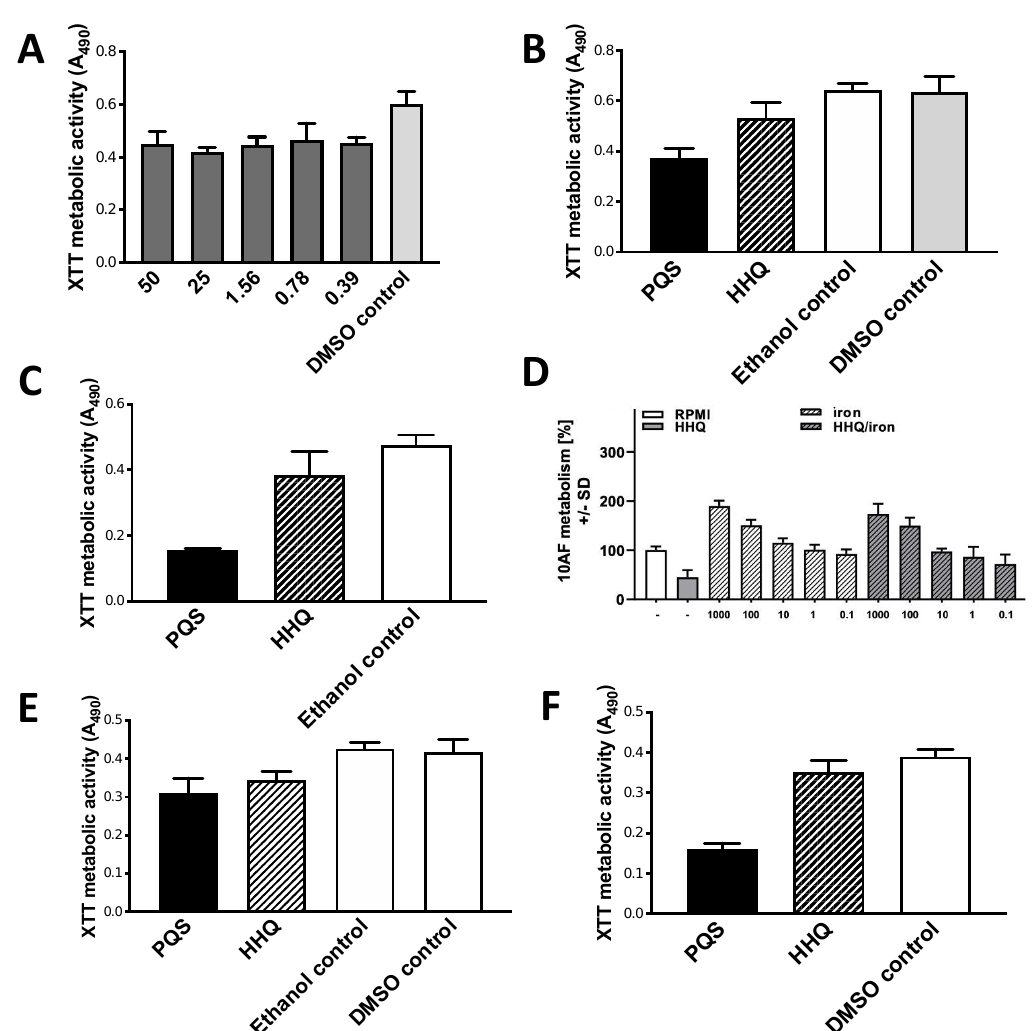
Figure 8. HHQ inhibits Af preformed biofilm; comparison to PQS. ( A ) Dose-response study with preformed 10AF biofilm. Flat dose-response shown. “DMSO control” is same concentration of DMSO diluent as present in test article wells. Twofold dilutions of HHQ were made from 50 to 0.39 µ g/mL. Bars showing results with 3.12–12.5 µ g/mL were not different from the 1.56 or 25 µ g/mL bars, so are not shown in order to simplify the figure. All concentrations shown were p < 0.001 compared to control except 0.78 µ g/mL, which was p < 0.01. ( B ) through ( F ): molecules tested at 1.56 µ g/mL. DMSO control results same as ethanol control or RPMI alone control, in every panel. ( B , C ), comparison with PQS. ( B ) HHQ and PQS inhibit strain 10AF compared to respective controls, p < 0.01 and p < 0.001, respectively. PQS more potent than HHQ, p < 0.001. ( C ) HHQ inhibits strain Af293 by 15%, but not significantly. PQS different from HHQ and control, p < 0.001 both comparisons. ( D ) Reversal of inhibition by Fe, no boosting above Fe alone at high Fe concentrations, Af strain 10AF. Fe was diluted twofold from 1000 to 0.1 µ M final concentrations (these are the numbers on the x axis), in presence or absence of HHQ. Data presented as % of controls. HHQ alone was inhibitory compared to control, p < 0.001 (left two bars). At Fe 0.1 µ M + HHQ (right bar), inhibition by HHQ is partially reversed; the combination still shows inhibition compared to control ( p < 0.05), but less inhibition ( p < 0.05) compared to HHQ alone. Fe 1–10 µ M completely reverses HHQ inhibition in combination (2nd and 3rd bars from right), these are not significantly different from control, and Fe 10 µ M + HHQ is p < 0.05 compared to HHQ alone. Fe alone at 10 µ M (5th bar from left) begins to significantly boost Af metabolism ( p < 0.05 compared to control) and higher concentrations are p < 0.001 compared to control. HHQ inhibition in combinations blunts the Fe boosting about 10-fold, since it is not until the combination of HHQ with Fe 100 µ M (4th bar from the right) that there is significant boosting above control ( p < 0.01; Fe 1000 µ M is p < 0.001 compared to control). No combination of HHQ with high concentrations of Fe is boosted above the same concentration of Fe alone. Studies in hypoxic conditions, Figure 8 E , F . In 8 E , strain 10AF, HHQ and PQS inhibit to 82% and 73% of respective controls, both p < 0.001; not significantly different. In 8 F , strain Af293, HHQ and PQS inhibit to 87% and 40% of respective controls, p < 0.05 and p < 0.001, respectively. HHQ and PQS effect differ by p <